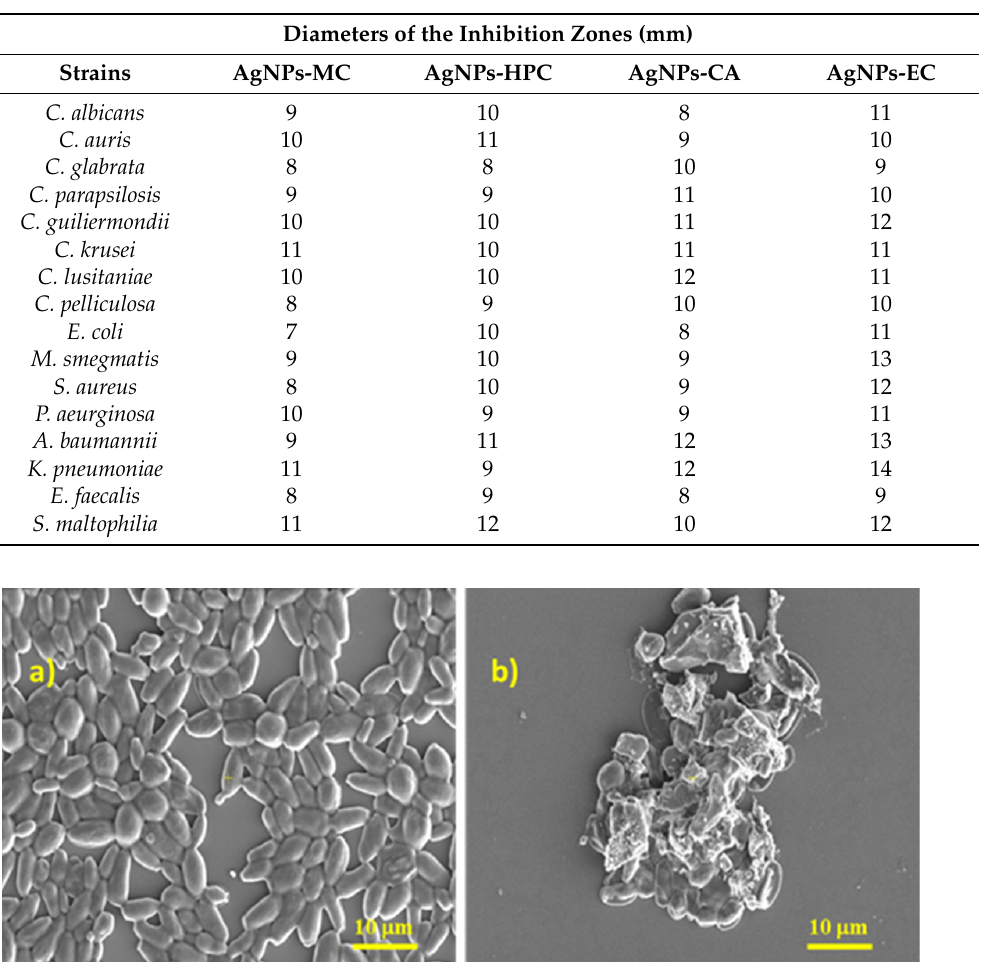
Table 3. The diameters of the inhibition zones in the antimicrobial activity test of AgNPs against microbial strains.